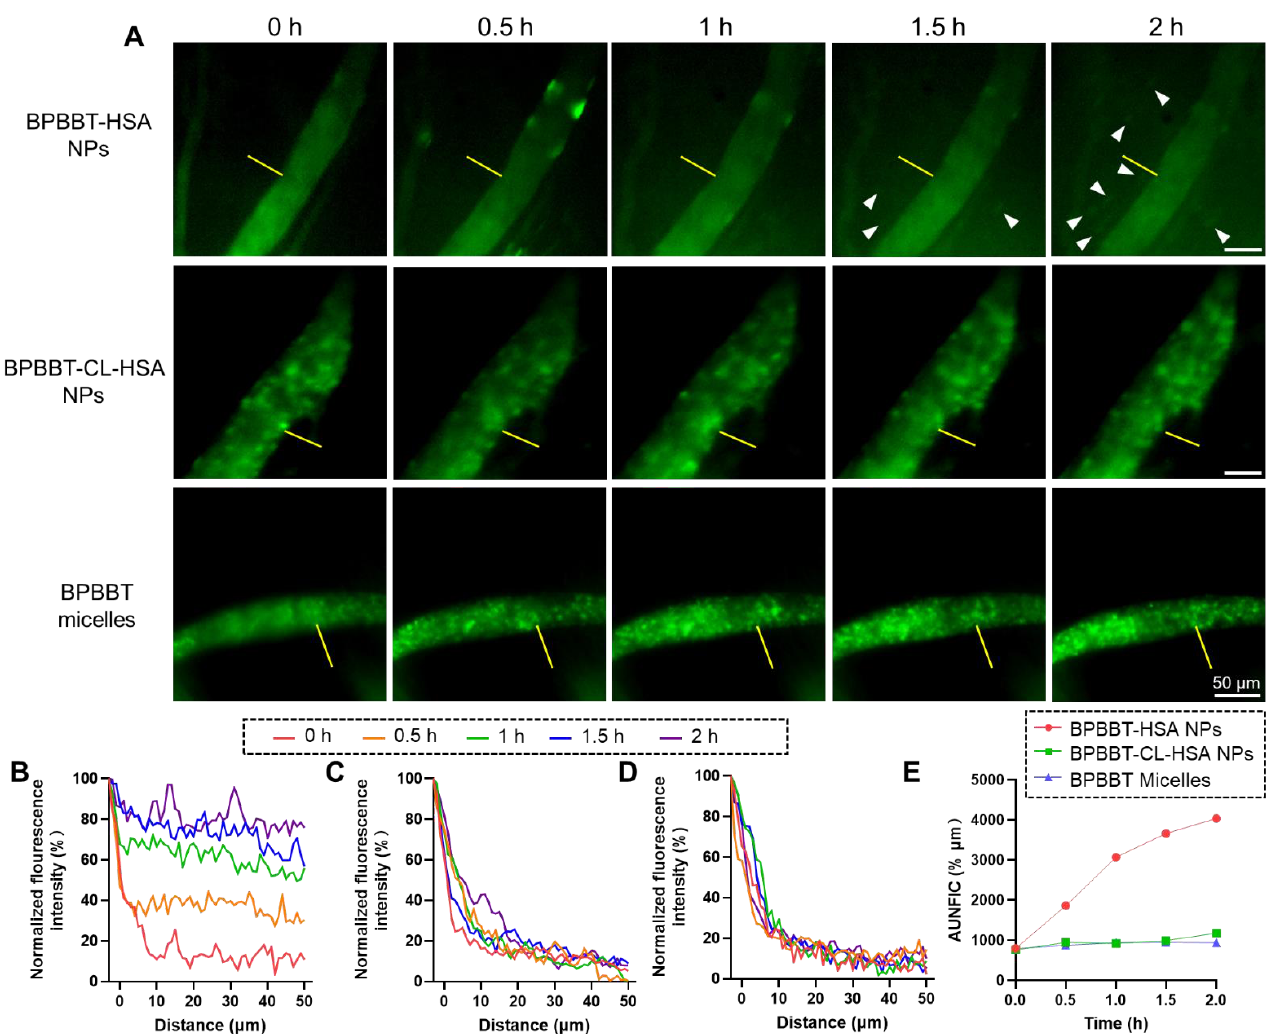
Figure 6. Intravital fluorescence imaging of the extravasation of different types of BPBBT NPs in the orthotopic CT26-Luc tumor of mice. ( A ) The distribution of BPBBT-HSA NPs (Video S1), BPBBT-CL-HSA NPs (Video S2) and BPBBT micelles (Video S3) in the CT26-luc tumor at different times after the injection, respectively. Green, the fluorescence signal of BPBBT. Arrows, the fluorescence signal of focal spots in the tumor interstitium. ( B – D ) Plots of the fluorescence intensity of BPBBT-HSA NPs ( B ), BPBBT-CL-HSA NPs ( C ) or BPBBT micelles ( D ) at different time points as a function of the distance from the blood vessel in a representative region marked by the yellow line in ( A ). ( E ) The area under the normalized fluorescence intensity-distance curve (AUNFIC) of BPBBT-HSA NPs, BPBBT-CL-HSA NPs and BPBBT micelles at different times post-injection, respectively.